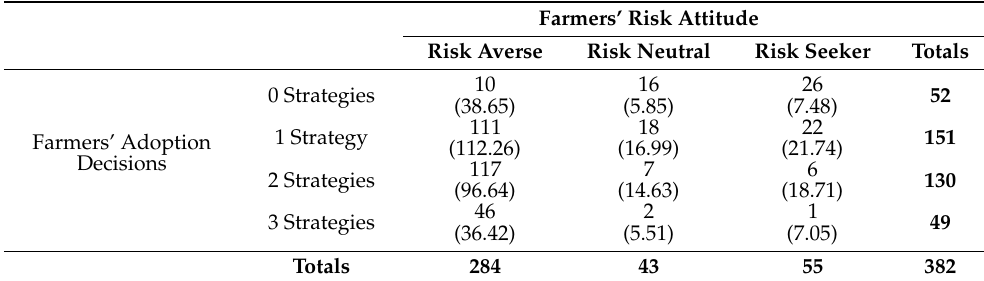
Table 8. Observed and Estimated Expected (in Parentheses) Counts.